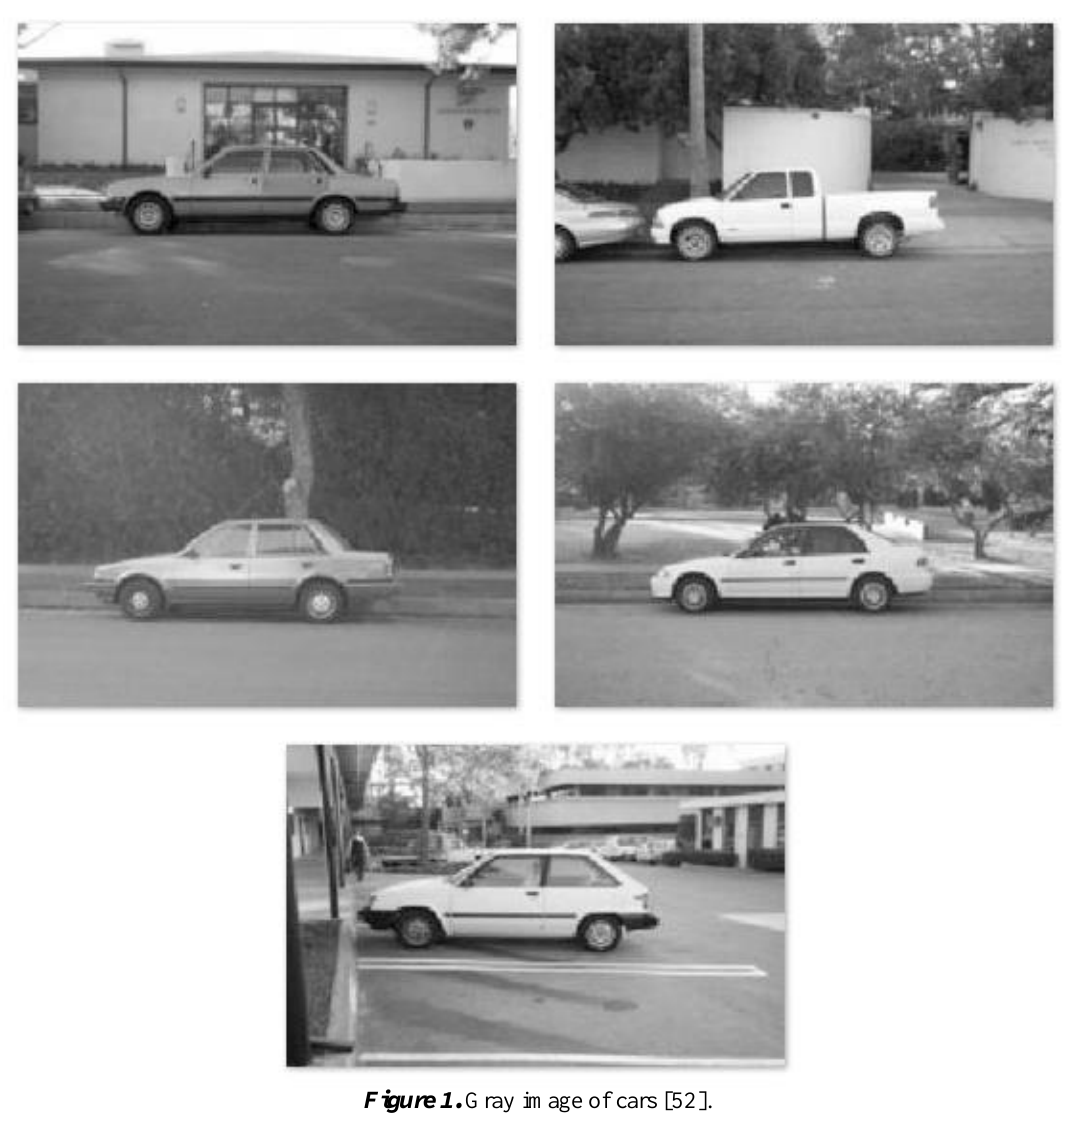
Figure 1. Gray image of cars